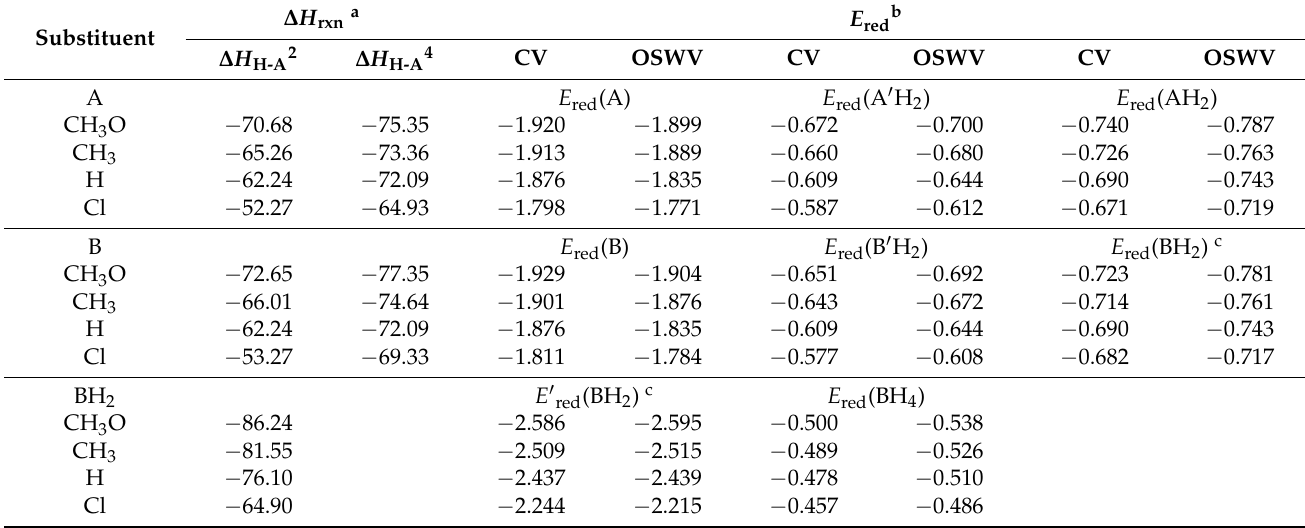
Figure 2. Cyclic voltammetry (CV) and Osteryoung square wave voltammetry (OSWV) of unsatu- rated ketone A(R = OCH 3 ) ( a ) and an anion accepting a hydride anion at position 4 A(R = OCH 3 ) ( b ) in deaerated acetonitrile containing 0.1 M n-Bu 4 NPF 6 as supporting electrolyte. Solid line: CV graph (sweep rate = 0.1 V/s); dashed line: OSWV graph. The CV values are cathodic peak potentials if the CV figure does not have peaks and troughs. CV and OSWV graphs all have two troughs s or peaks, and one part s is visible. Table 1. Reaction Enthalpy Changes of the Unsaturated Three Carbonyl Compounds in Acetonitrile at 298 K (kcal/mol) and Reduction Potentials (V vs Fc +/0 ) of A, B, A’H 2 , B’H 2 , AH 2 , BH 2 in Acetonitrile at 298 K.